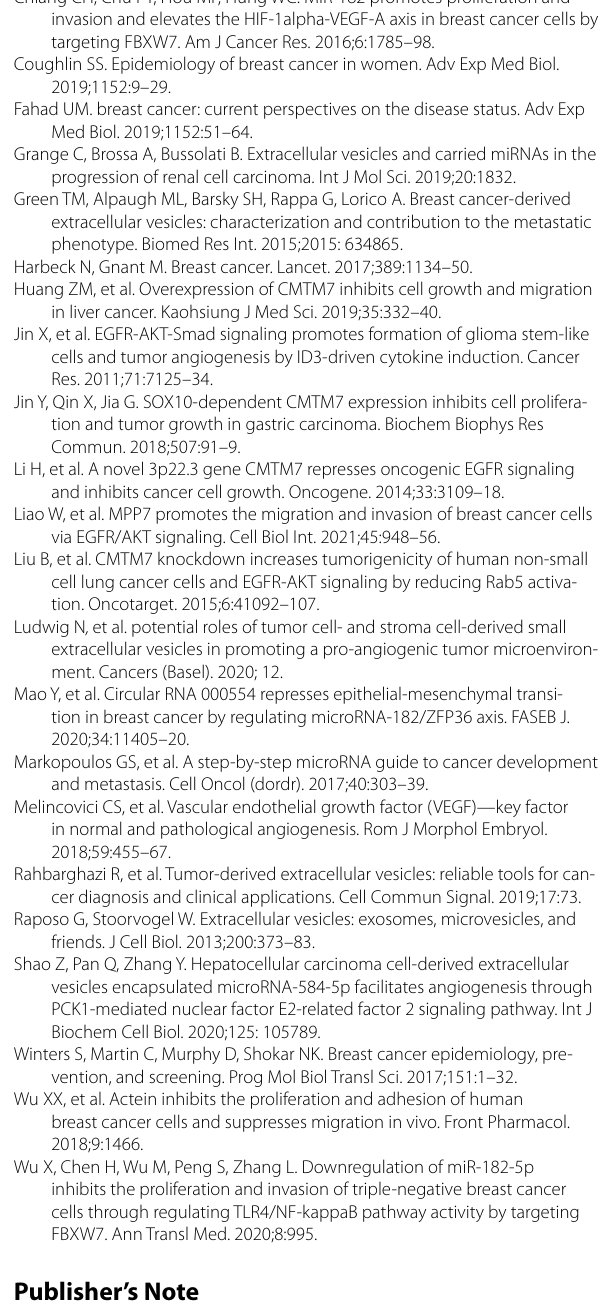
Additional file 4: Fig. S3. Molecular mechanism of EVs derived from tumor cells carrying miR-182-5p affect the breast cancer. Breast cancer cell-derived EVs transferred miR-182-5p to HUVECs, where it targeted CMTM7 and activated the EGFR/AKT signaling pathway, thus promoting the occurrence and development of breast